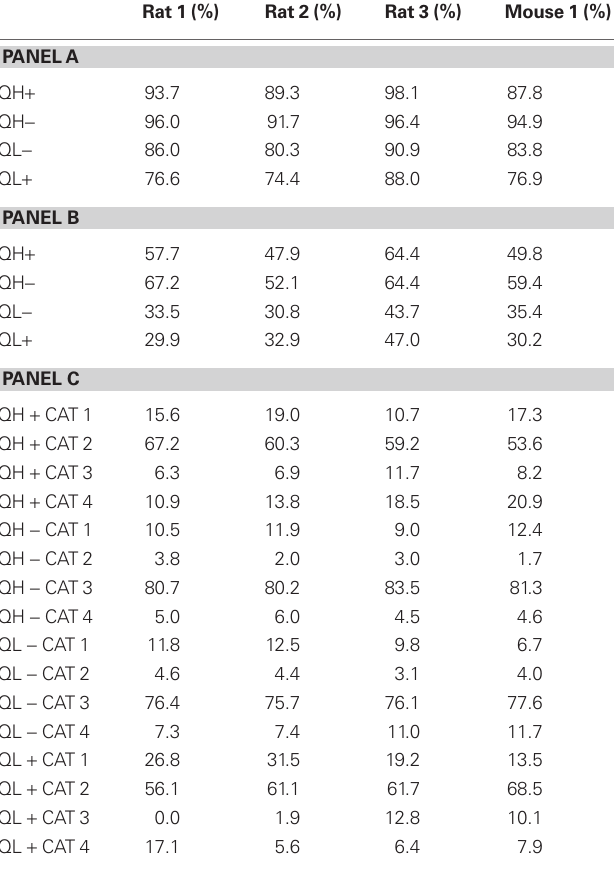
Table 2 | Statistical comparison of ripple amplitude and frequency dynamics. (A) The percentage of ripple events that have at least one large positive FM peak or one large negative FM peak in each partition. (B) The percentage of ripple events in each partition where both the positive and negative FM peak are large. (C) The proportion of ripple events categorized by the relative timing of max. amplitude peak, max. frequency, and min. frequency. The categories are (1) both max. and min. iFreq occur before, (2) only the min. iFreq occurs before, (3) only the max. iFreq occurs before, or (4) both min. and max. iFreq occurs after the amplitude peak of the ripple. For panel (C) , only events with both large negative and large positive FM were